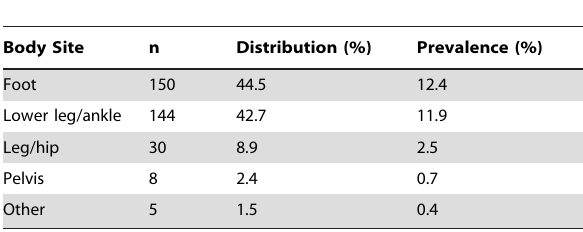
Table 8. Number of active ultramarathon runners (among 1,212) reporting a lifetime history of a stress fracture involving specified body sites and relative distribution and prevalence of stress fracture for each site.